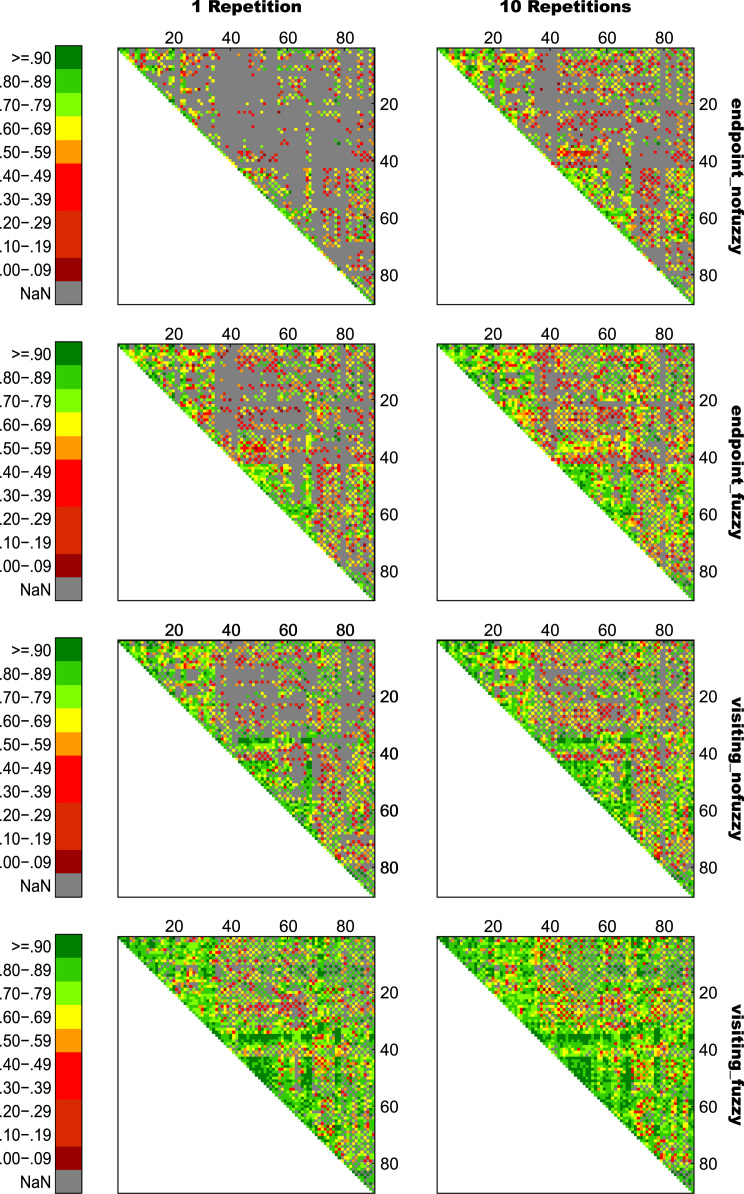
Seed-specific ICC(2,1) values for all connections of Model 2, estimating the between-session reproducibility of all eight variants of reconstruction repetitions×streamline selection variant. Numbers on the x- and y-axis refer to AAL seed numbers. For visualization purposes, negative ICC(2,1) values were set to zero (0.28% of values).